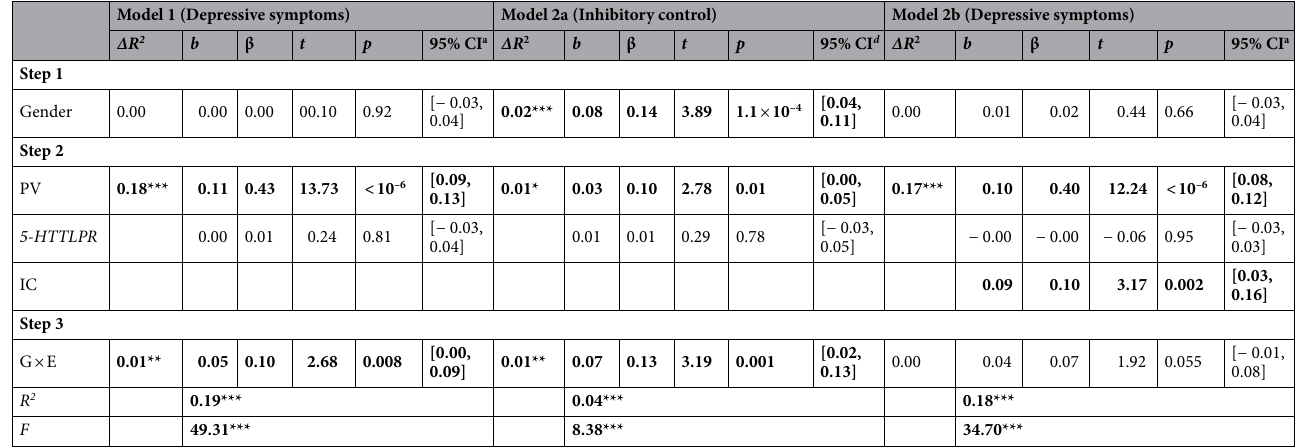
Table 2. Test of mediated moderation. Significant results are highlighted by bold face. PV peer victimization (standardized); IC inhibitory control; G × E 5-HTTLPR × peer victimization. a Bootstrapping based confidence